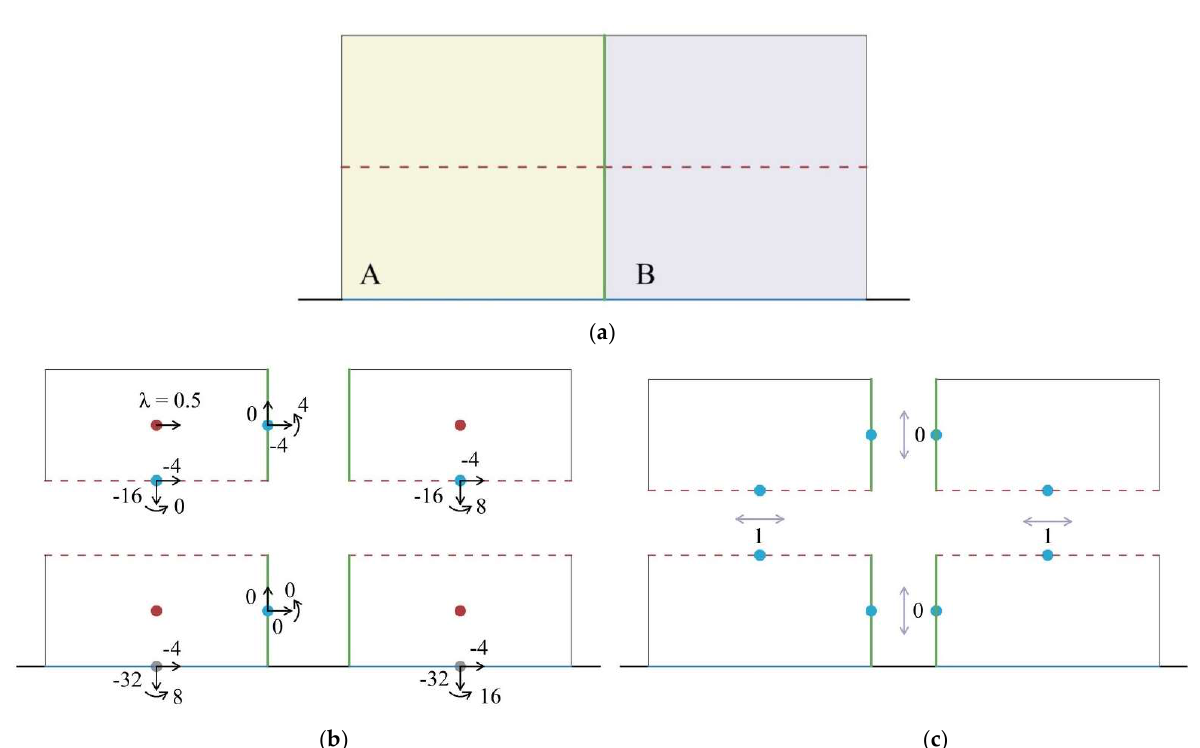
Figure 6. ( a ) The optimization result with limit analysis for the 2D problem generating two segments, including: ( b ) the load factor and the internal forces (in Newton) and moments (in Newton-meter); ( c ) the shear strength at each interface. Capital letters A and B are used to enumerate the segments.